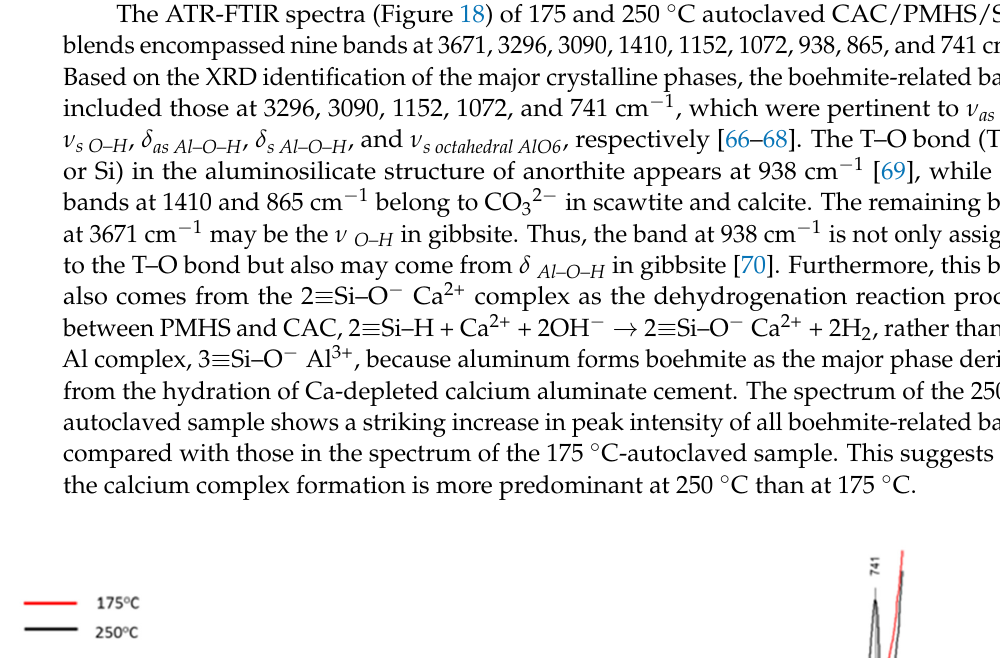
Figure 17. XRD pattern of foam cement made by dehydrogenation reactions between CAC hydrates, PMHS, and SMS, which was followed by autoclaving at 250 °C.